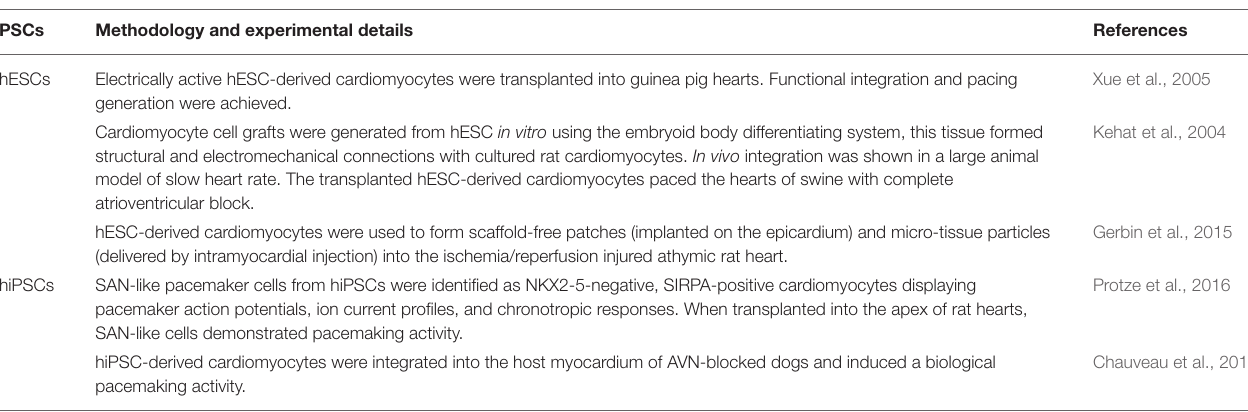
TABLE 2 | Cell-based biopacemaking approaches by PSC differentiation into cardiomyocytes. PSCs Methodology and experimental